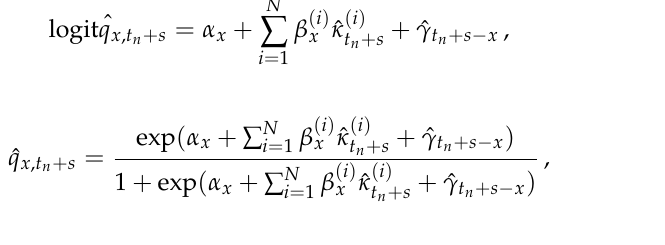
( i ) , i = 1,2,3 of male and female t